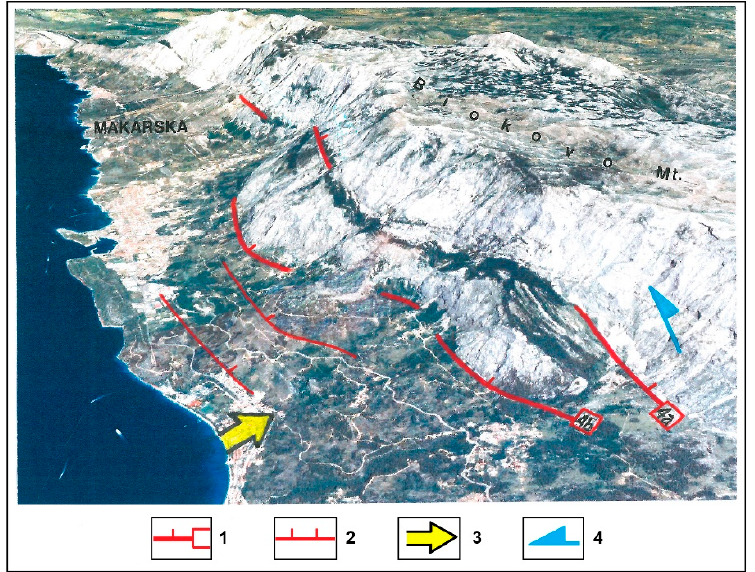
Figure 9. Mosor–Biokovo–Dubrovnik fault zone (4a,b), its branches, and steep relief of Biokovo